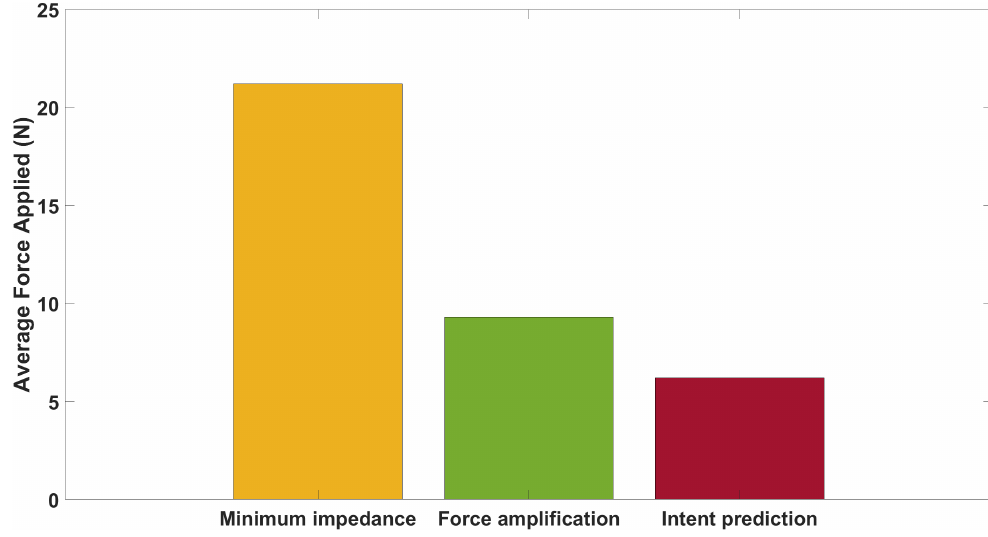
Figure 30. Cutting forces applied by the user using the intent prediction module for 30 cm cutting of the foam. The blue line is the force applied with K min and D min only (i.e. minimum impedance), while the red line is the force applied with K min and D min and the intent prediction module.